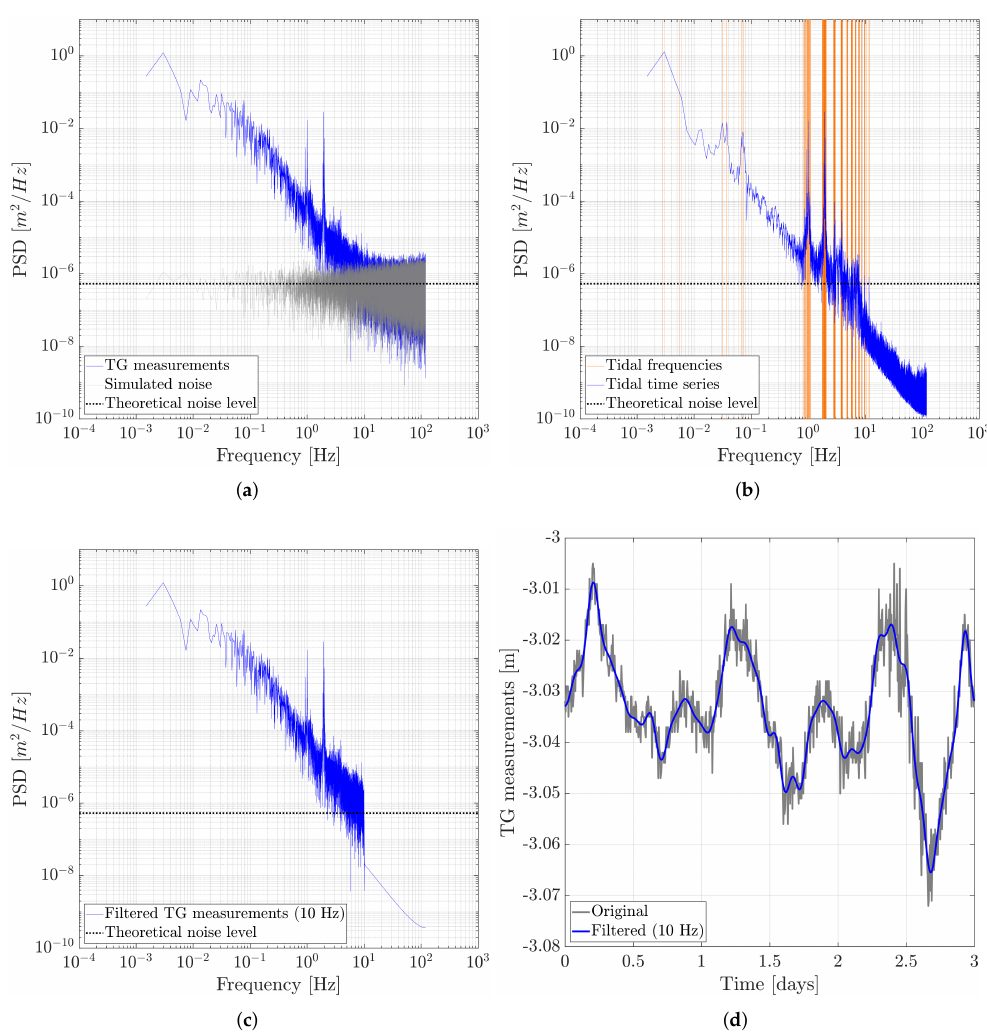
Figure 7. Power spectral densities of ( a ) original SVR2 tidal observations, ( b ) tidal constituents and ( c ) filtered SVR2 measurements. ( d ) Comparison of original and filtered SVR2 time